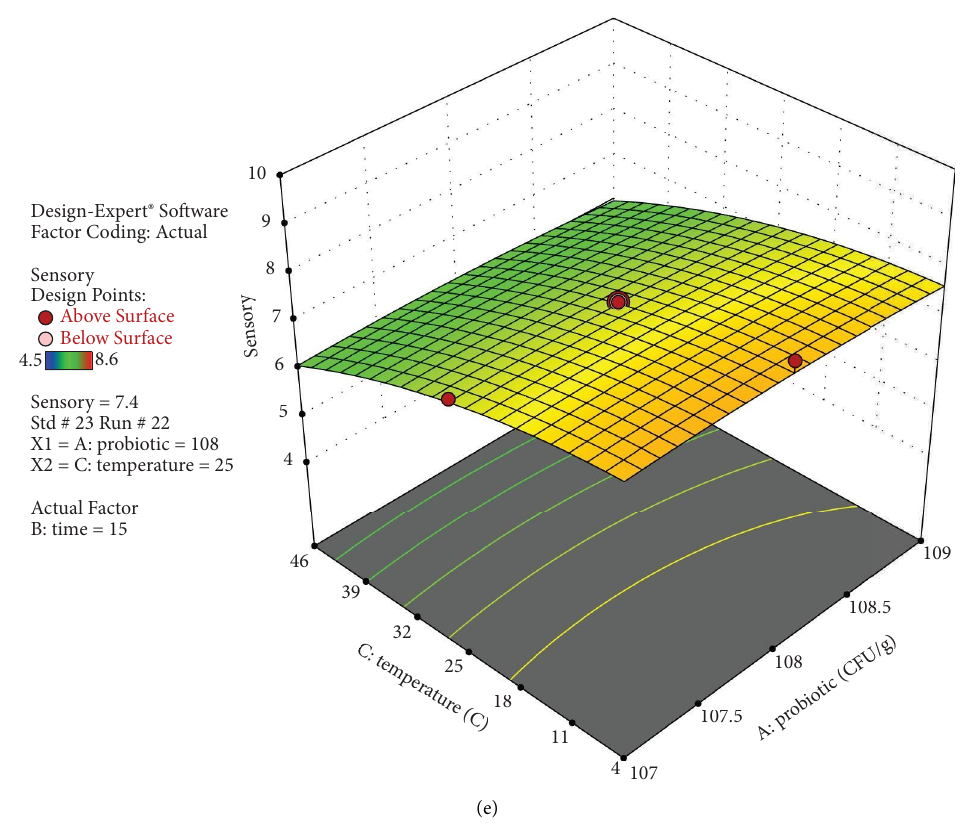
Figure 8: Te efect of storage time (15 days) on the overall acceptance of pistachio